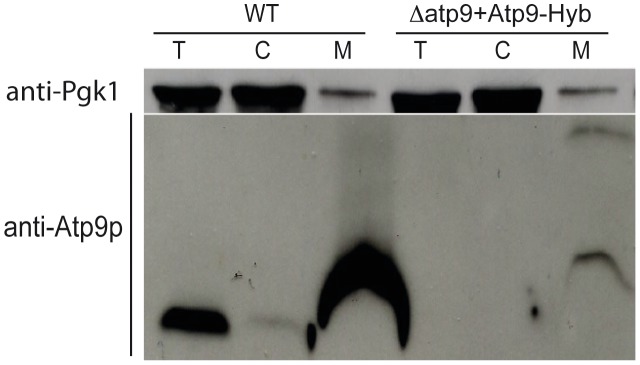
Reducing the hydrophobicity of the first transmembrane segment of yeast Atp9p improves its import into mitochondria.The Δatp9 strain was transformed with a hybrid Atp9 gene (Atp9-Hyb) encoding the mitochondrial targeting sequence (MTS) and first transmembrane segment (TMH1) of the PaAtp9-7 protein, followed by the connecting loop and second transmembrane segment (TMH2) of yeast Atp9p (see Figure 2A for amino acid sequence and Figure S3E for nucleotide sequence). Total cellular (T), mitochondrial (M) and post-mitochondrial supernatant (C) protein extracts were prepared from WT and Δatp9+Atp9-Hyb strains. Samples were separated by SDS-PAGE and probed with antibodies against yeast Atp9p and the cytosolic protein Pgk1p (phosphoglycerate kinase).